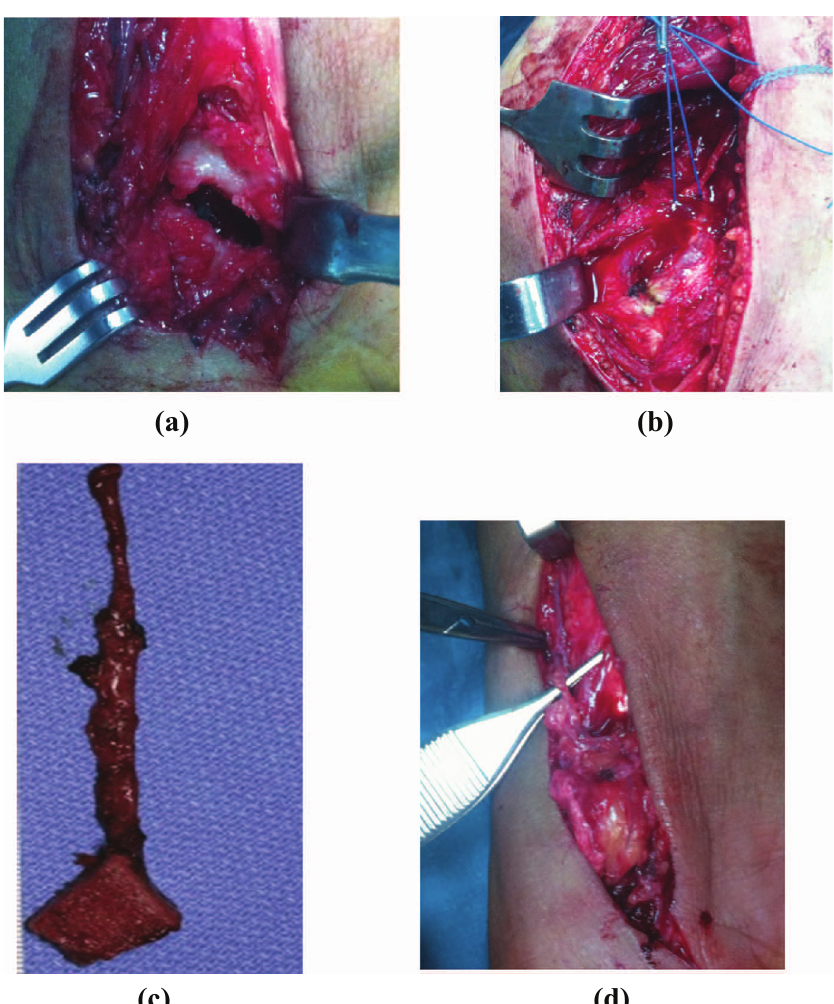
Figure 4. Intraoperative images, a) non-united scaphoid fracture site; b) harvesting vascularised MFC graft; c) graft with vascular pedicle; d) graft after vascular